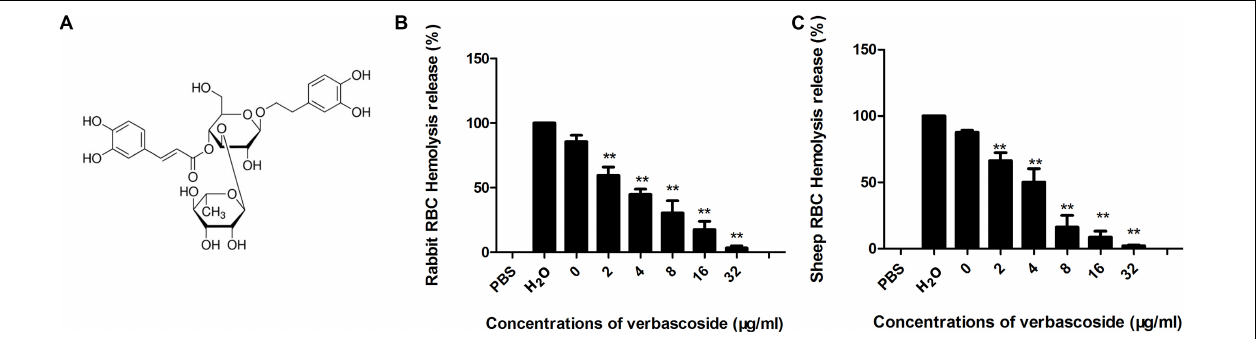
FIGURE 1 | Verbascoside inhibits CPA and PFO hemolytic activity. (A) Chemical structure of verbascoside. (B,C) Hemolytic assays were performed by the coincubation of PFO and rabbit red blood cells or CPA and sheep red blood cells in PBS buffer. The hemolytic activity of each sample was determined by comparing the OD 543 nm values of the supernatant sample and control sample treated with H 2 O (without verbascoside, used as 100%). The data are shown as the mean ± SD values of three independent experiments. P -values were calculated using one-way analysis of variance (ANOVA) (** P < 0.01).